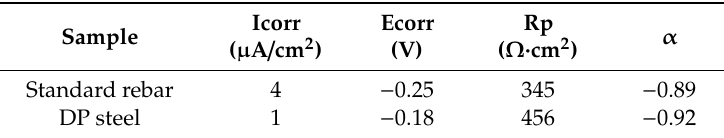
Figure 14. SEM images obtained after immersion in 0.015 M NaHCO 3 + 0.005 M Na 2 CO 3 (pH = 9.0) solution. ( a ) Standard rebar and ( b ) DP steel. Table 6. EIS results for DP steel and standard rebar in 0.015 M NaHCO 3 + 0.005 M Na 2 CO 3 (pH = 9.0) solution.